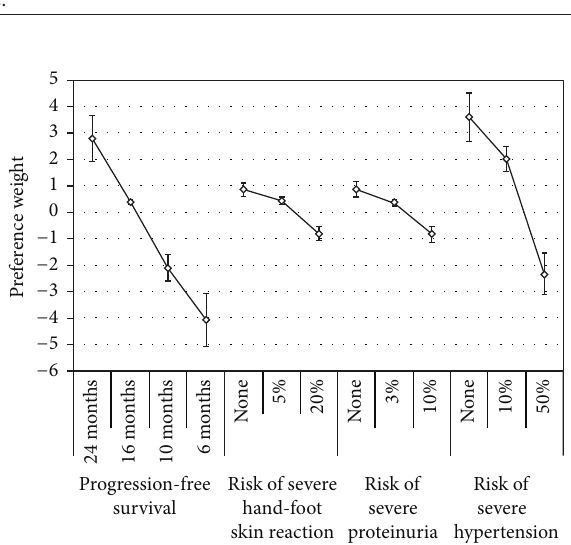
Figure 1: Preference weights ( 𝑁 = 134 ). Only relative differ- ences matter when interpreting preference weights. The differences between adjacent preference weights indicate the relative impact of moving from one level of an attribute to an adjacent level of that attribute. Note: the vertical lines around each mean preference weight denote the 95% confidence interval about the point